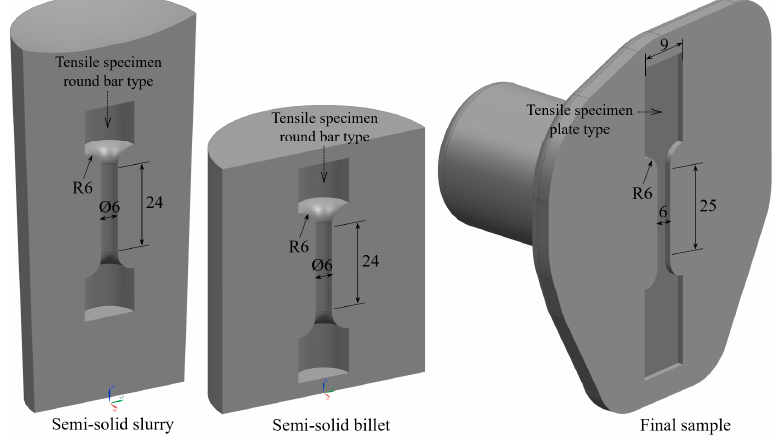
Figure 2. Dimension of tensile specimens and location machined in samples.